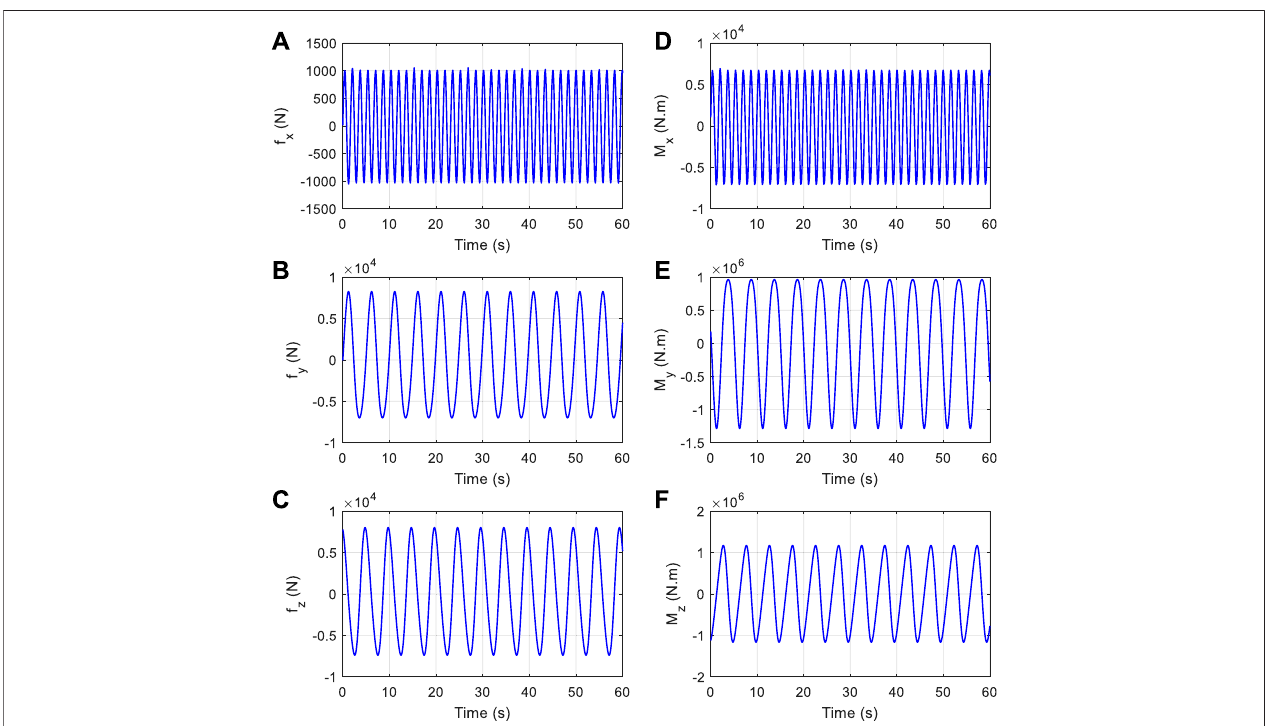
FIGURE 7 | Equivalent wind forces. (A) fx(t); (B) fy (t); (C) fz(t); (D) Mx(t); (E) My(t) and (F) Mz(t).